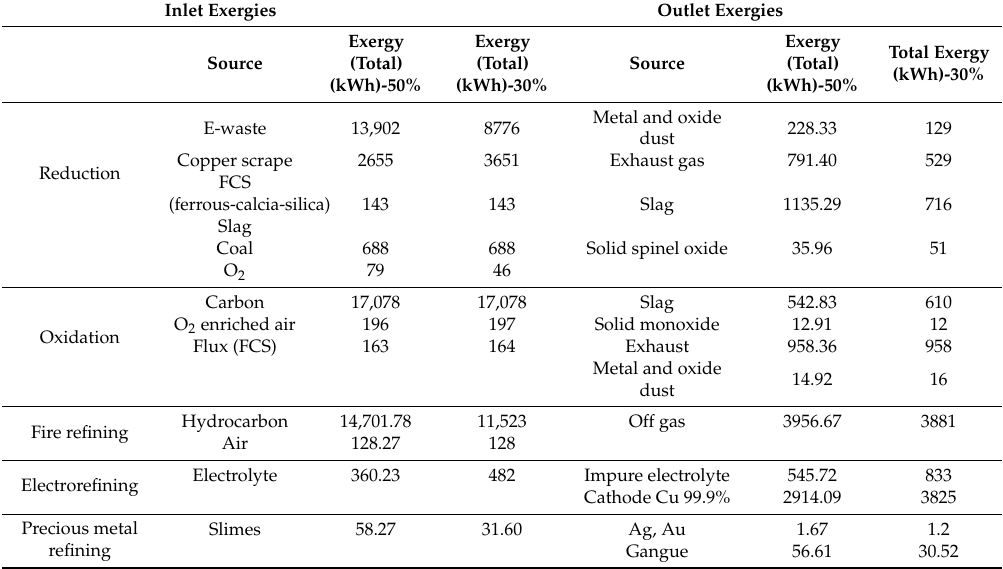
Table 4. Values of exergies of process units involved in electronic waste (e-waste) treatment through the copper recycling process.